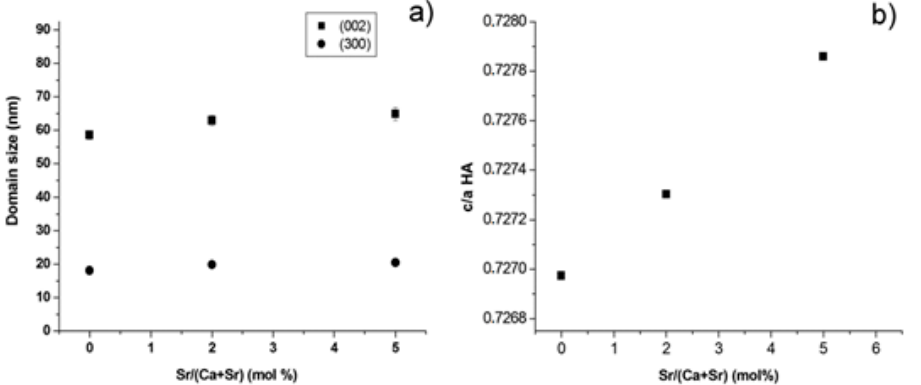
Figure 2. ( a ) Coherent domain size in Sr-HA phases along the ab plane and the c axis; and ( b ) distortion of the HA lattice with strontium doping.